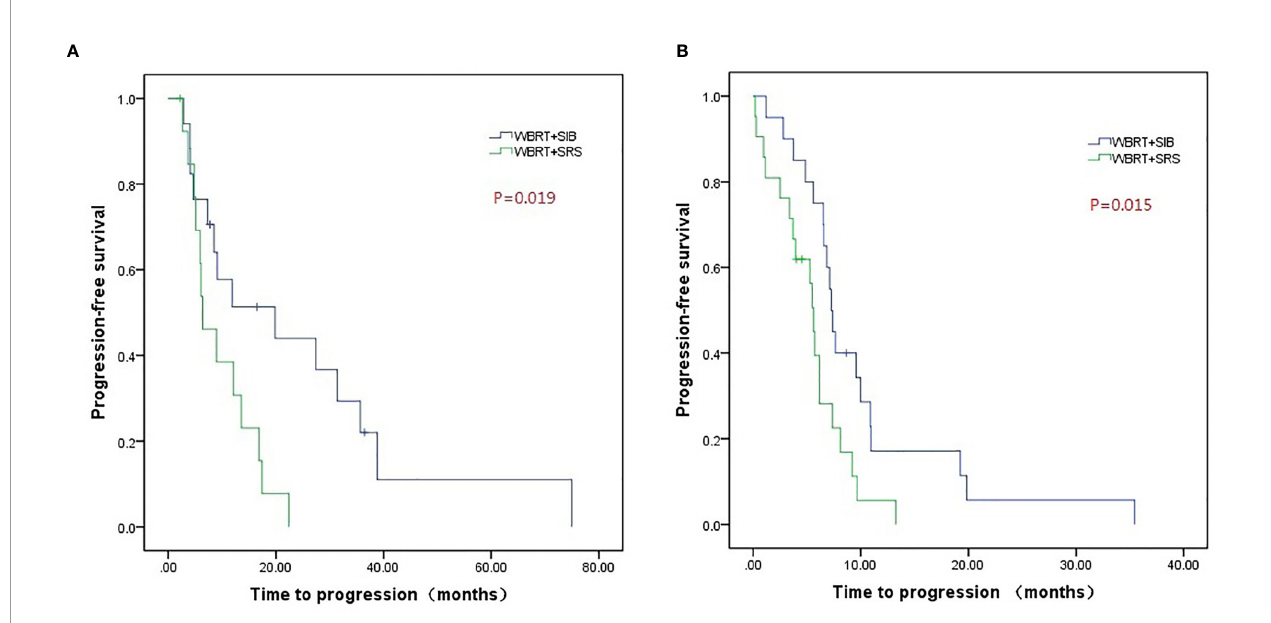
FIGURE 3 | Compared intracranial progression-free survival of WBRT + SRS and WBRT + SIB in patients with (A) or without targeted therapy (B) .